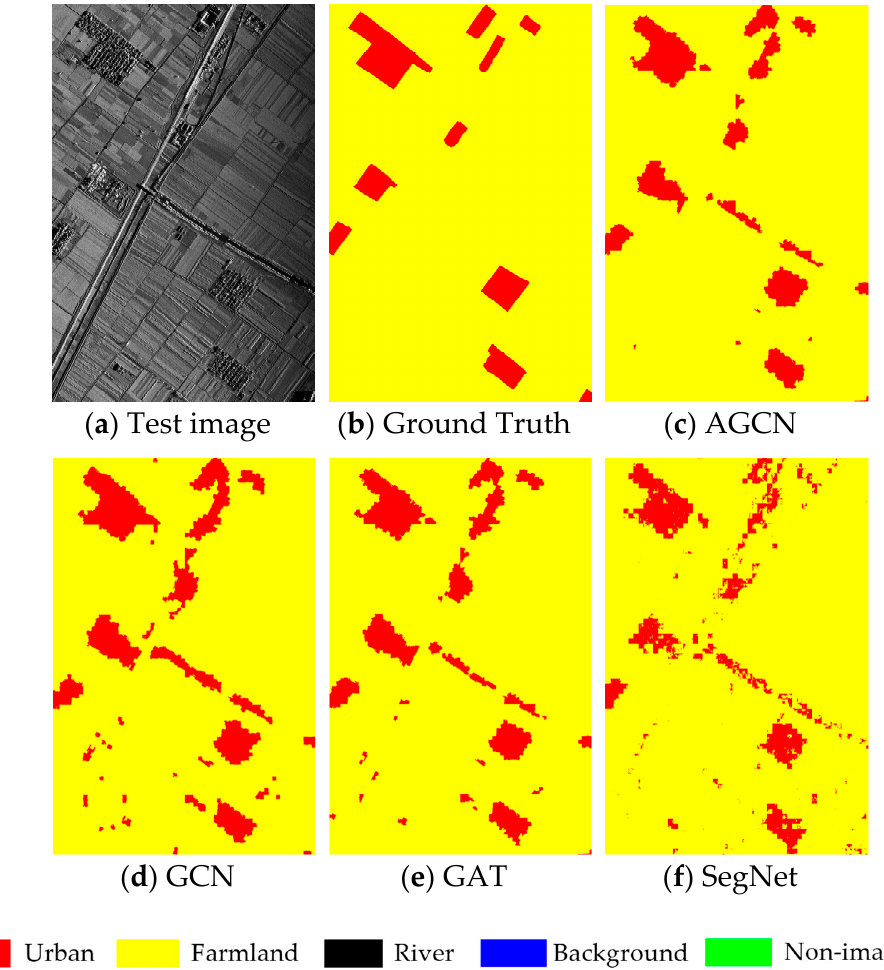
Figure 6. Segmentation results of four models on the Pucheng dataset. ( a ) Input image; ( b ) ground truth; ( c ) AGCN; ( d ) GAT; ( e ) GCN; ( f ) SegNet.